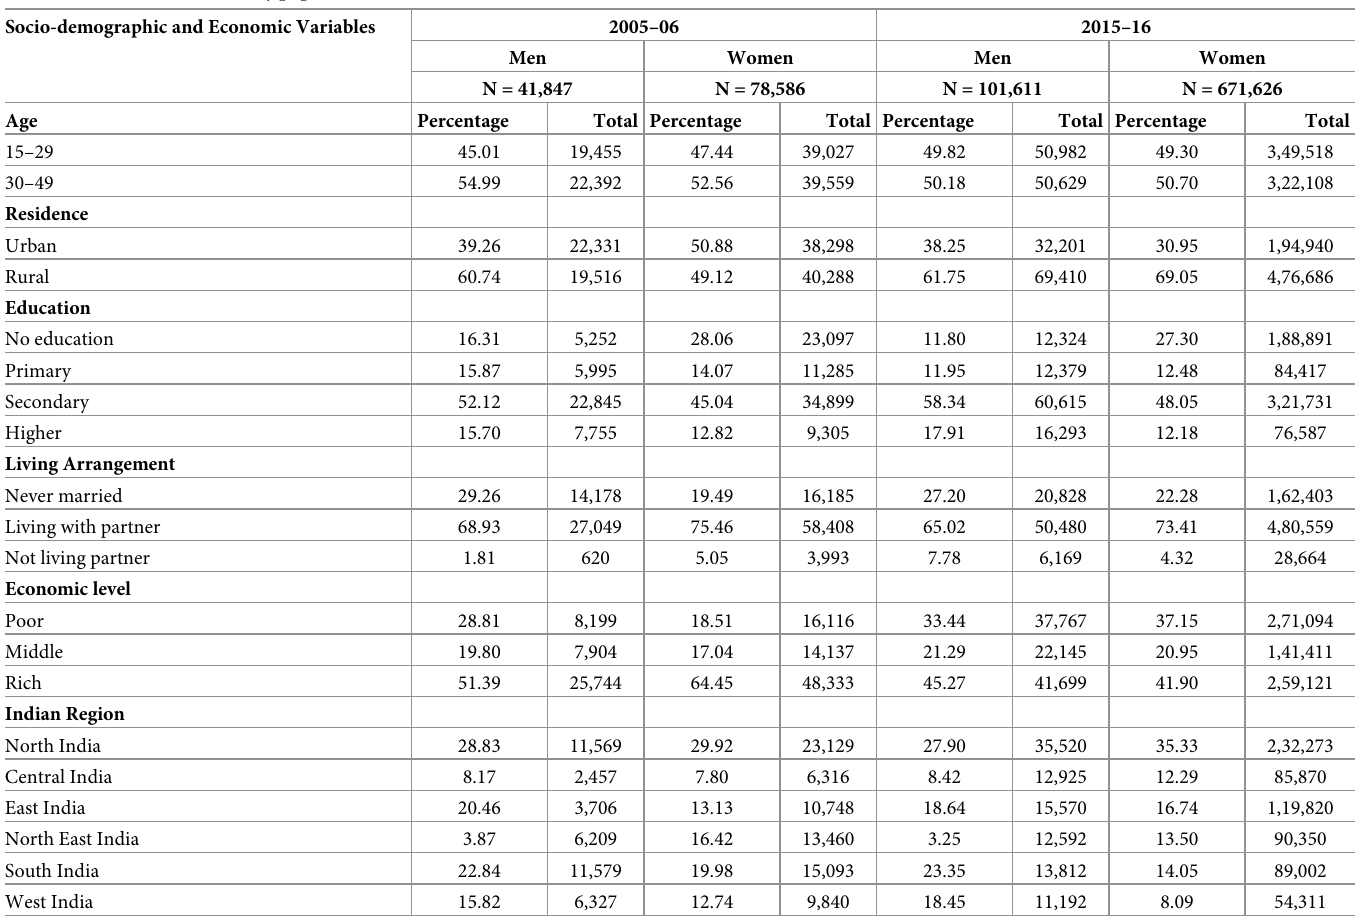
Table 1. Characteristics of study population, India, NFHS, 2005–06 & 2015–16.